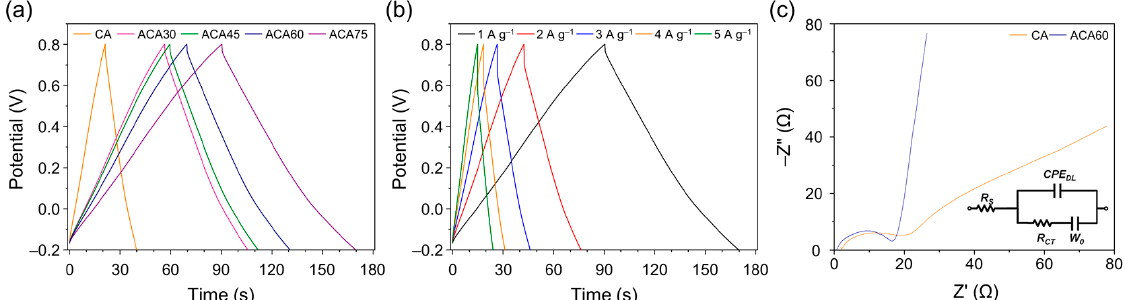
Figure 6. ( a ) GCD curves of CA and ACA electrodes obtained at a current density of 1 A g − 1 , ( b ) GCD curves of ACA60 electrode obtained at different current densities (1–5 A g − 1 ), and ( c ) Nyquist plots of CA and ACA60. Table 2. Specific capacitances of samples (F g − 1 ).